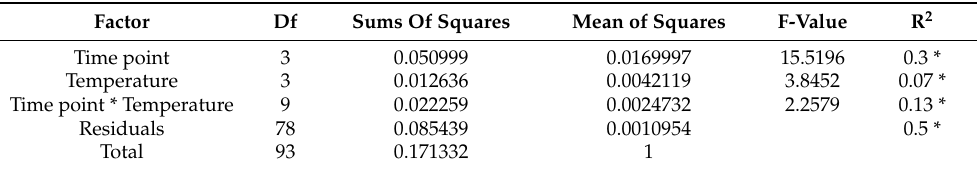
Table 6. Effects of temperature and time on the metabolites in Planktothricoides sp. (SR001)— PerMANOVA.